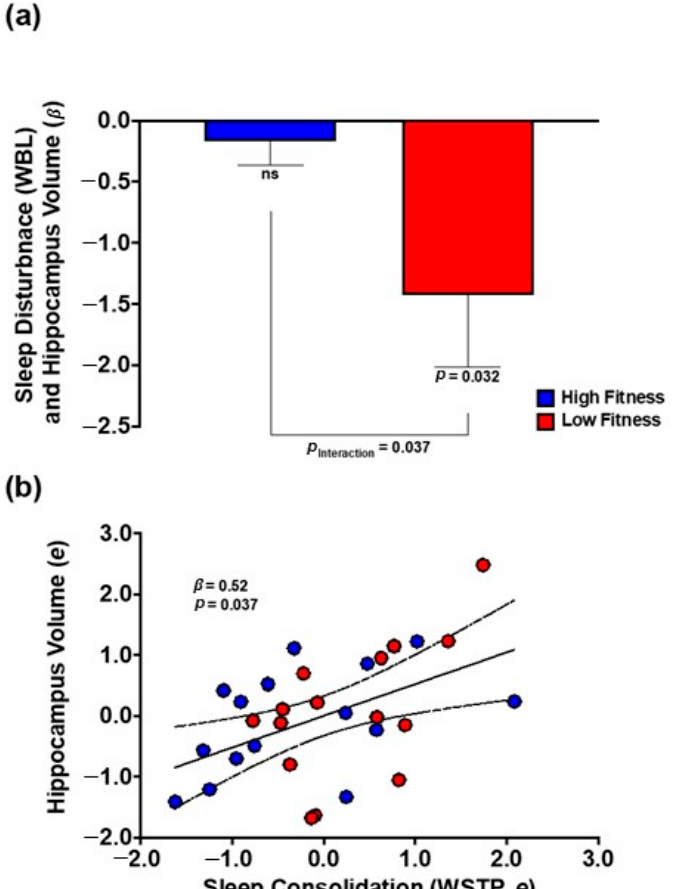
Figure 3. Relations between sleep, fitness, and hippocampal volume in older adults. ( a ) Cardiorespiratory fitness (HRR M ) moderates the adverse association between wake bout length (WBL) and hippocampal volume. Bars depict standardized regression coefficients ( β ) for the sleep × fitness interaction (controlling for mean-centered age) for more-fit ( blue ) and less-fit ( red ) individuals. Among less-fit individuals ( red ), longer WBL is associated with smaller hippocampal volume. This association was not significant for more-fit individuals ( blue ). Error bars depict standard error. ( b ) Across fitness groups, greater sleep consolidation (WSTP) is associated with increased hippocampal volume (controlling for mean-centered age). X and Y axes reflect the standardized residual values for sleep consolidation (WSTP) and hippocampal volume, respectively. Dotted lines indicate the 95% confidence interval.